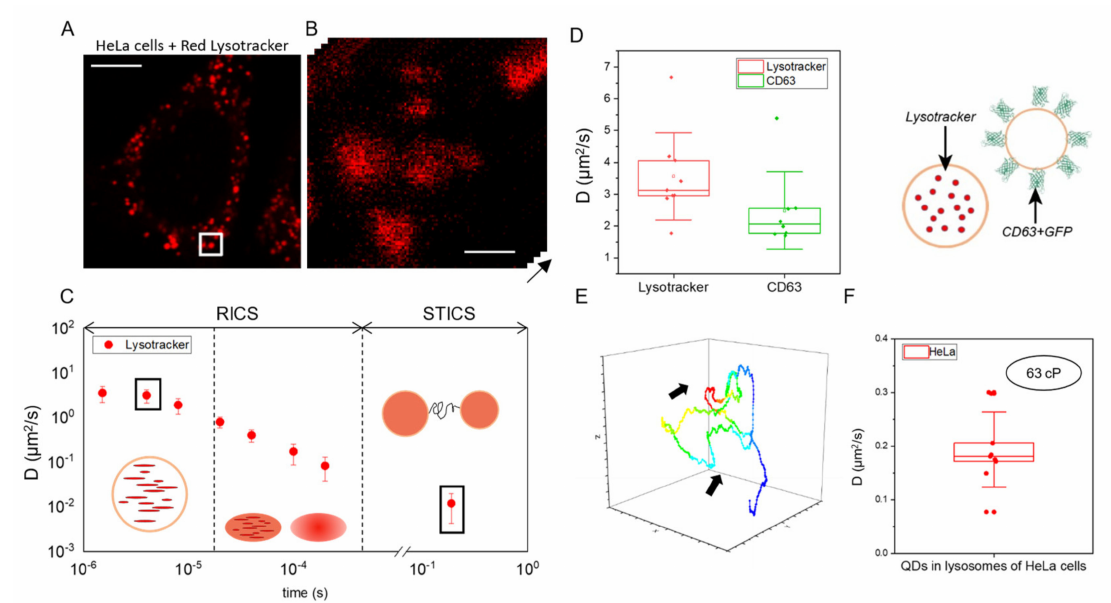
Figure 2. Time-tunable RICS: validation tests in living cells ( A ) Confocal image of a HeLa cell labeled with Red Lysotracker (scale bar 10 µ m). ( B ) Magnification of the area used for the time-tunable RICS experiments (i.e., 33 nm per pixel, white square in ( A ). ( C ) Plot of the diffusion coefficients measured at different scan speeds for Lysotracker-labeled lysosomes. As schematically represented, at short pixel dwell times (i.e., few microseconds) RICS can probe the movement of the molecules inside the organelle. By contrast, at long pixel dwell times (i.e., hundreds of microseconds), RICS cannot distinguish fast molecular movements within the lysosome from the slow movement of the entire organelle; this latter component can be isolated and quantified by STICS. Standard deviations associated to data points are within 10–20% of the mean value: they are not discernible due to the logarithmic scale used on the y -axis ( D ) On the left: plot of the diffusion coefficients of Red Lysotracker (red) and GFP-labeled CD63 (green) measured on lysosomes of HeLa cells obtained at 4 µ s of pixel dwell time. Upper and lower edges of the boxes represent the 25 and 75 percentiles of the distributions found, the middle line shows the mean value, whiskers show standard deviations; on the right: schematic representation of the two distinct situations (right side). ( E ) Example of trajectory of a QD-loaded lysosome in HeLa cell obtained using feedback-based 3D orbital tracking at 4 µ s pixel dwell time. Ticks on axes represent pixels, thus 50 nm of space distance. Standard MSD analysis of this trajectory yields a diffusion coefficient of the tracked lysosome of 0.011 ± 0.009 µ m 2 /s (expressed as Mean ± SD). ( F ) Plot of the diffusion coefficients (expressed as mean ± SD) of both QDs loaded into lysosomes measured using the feedback-based 3D orbital tracking routine at 4 µ s pixel dwell